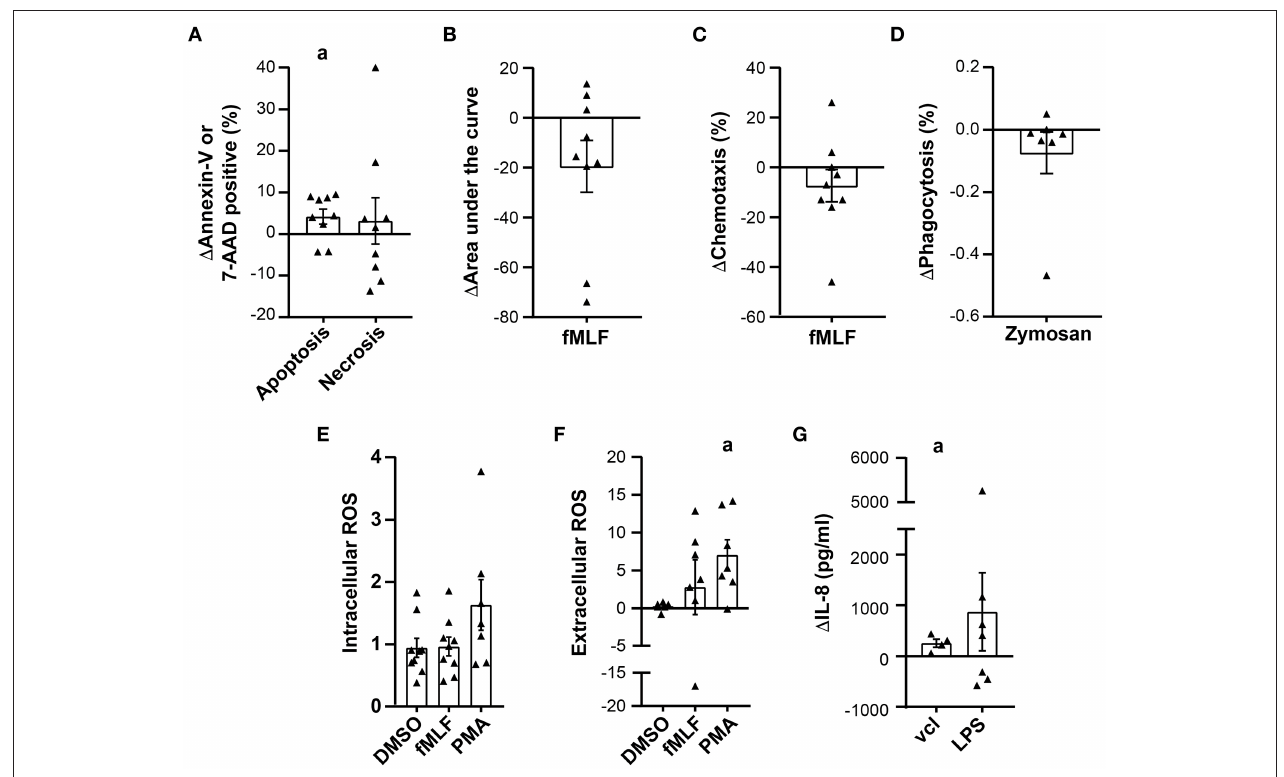
FIGURE 6 | Variation in prednisone GC neutrophil viability and function after 24h of storage. Viability and functional assay data are presented as the difference between the values obtained on the day of leukapheresis (D1) and 24h post-leukapheresis (D2), (D2-D1), in all graphs except in (E) . (A) Difference in the proportion of apoptotic and necrotic neutrophils determined by Annexin-V and 7-AAD staining, respesctively ( n = 9). (B) Difference in the fMLF-induced increase in intracellular calcium expressed as the area under the curve ( n = 9). (C) Difference in the maximal proportion of neutrophils that migrated across a chemotaxis chamber toward fMLF ( n = 9). (D) Effect of storage on the proportion of neutrophils that phagocytosed non-opsonized pHRodo Red Zymosan conjugated particles ( n = 7). (E) Neutrophil fMLF and PMA-induced intracellular ROS production expressed as a ratio of the MFI (D1/D2); n = 9 and n = 7, respectively. (F) Change in fMLF and PMA-induced superoxide anion production expressed as the difference in O 2 − produced on D1 and D2 ( n = 7). (G) Difference of IL-8 production expressed in pg/ml ( n = 8). Statistical analysis: One sample t test with a hypothetical mean of 0 [in (A–D,F,G) ] or 1 (in (E) was performed to determine the significance of the difference or ratio between values obtained on D1 and D2, a p -value <